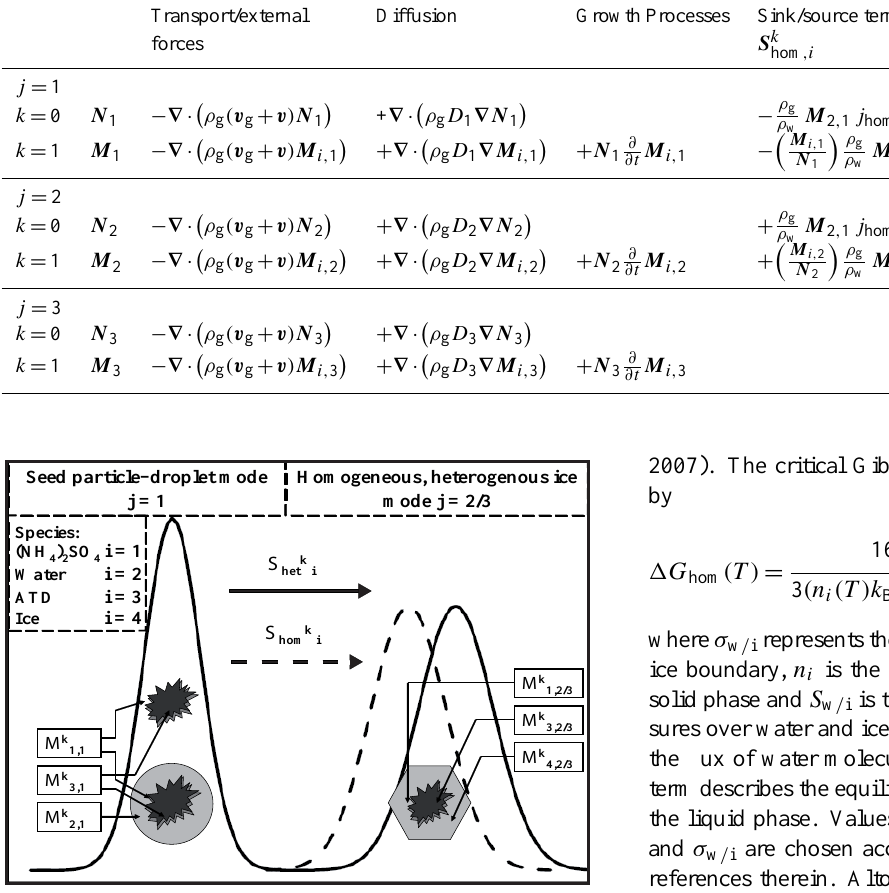
Fig. 12. Schematic of the phase transition in the numerical model Fig. 2. Schematic of the phase transition in the numerical model with regard of moments ( k ), modes ( j ) and species ( i ) given by with regard of moments ( k ), modes ( j ) and species ( i ) given by integral moments M k i,j . Sink and source term of the seed particle- integral moments M k . Sink and source term of the seed particle- droplet (solid line), the homogeneous (dashed line) and heteroge- i,j neous ice mode (solid line) described by S k hom ,i and S k het ,i , re- droplet (solid line), the homogeneous (dashed line) and heteroge- spectively. The modes given in this figure are broader for illus- neous ice mode (solid line) described by S k and S k , respec- hom ,i het ,i tration, whereas monodisperse modes are applied in the numerical tively. The modes given in this figure are broader for illustration, model. whereas monodisperse modes are applied in the numerical